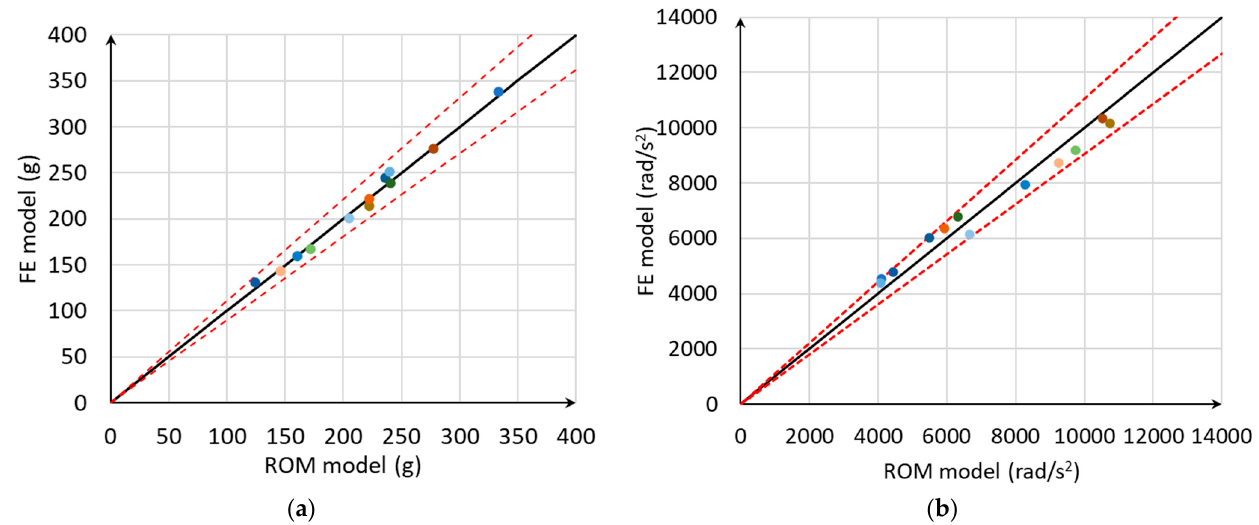
Figure 13. Scatter plots of prediction errors for both a peak ( a ) linear acceleration and a ( b ) rotational acceleration. ( b ) rotational